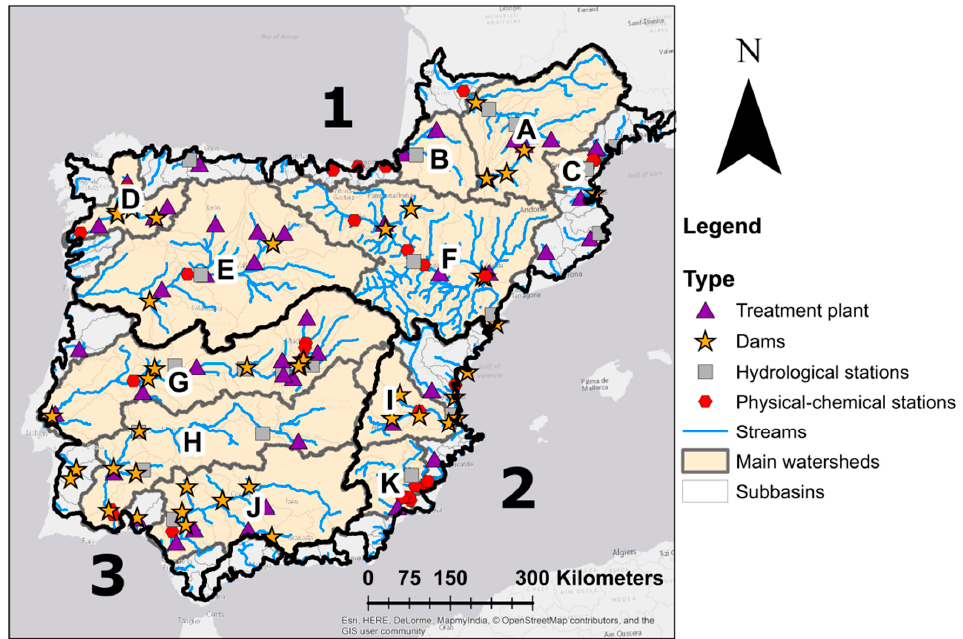
Figure 2. SUDOE models (( 1 ) Pyrenean project, ( 2 ) Mediterranean projet, ( 3 ) Oceanic Project; ( A ) Garonne, ( B ) Adour, ( C ) Aude, ( D ) Minho, ( E ) Duero, ( F ) Ebro, ( G ) Tajo, ( H ) Guadalquivir, ( I ) Jucar, ( J ) Guadiana, and ( K ) Segura).